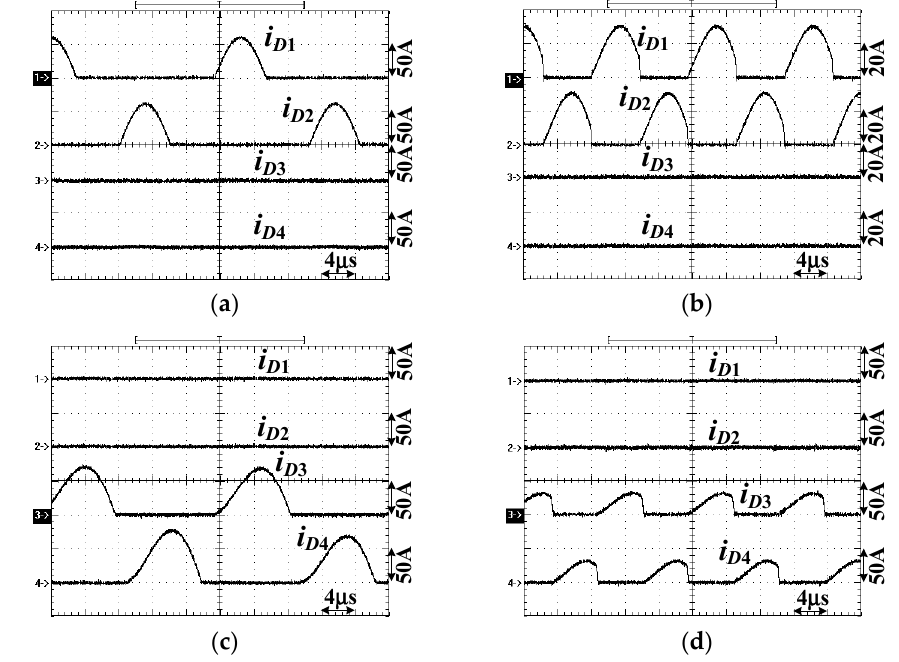
Figure 8. Measured results of the secondary side diode currents at rated power values of: ( a ) V in = 100 V; ( b ) V in = 190 V; ( c ) V in = 210 V; ( d ) V in = 400 V.